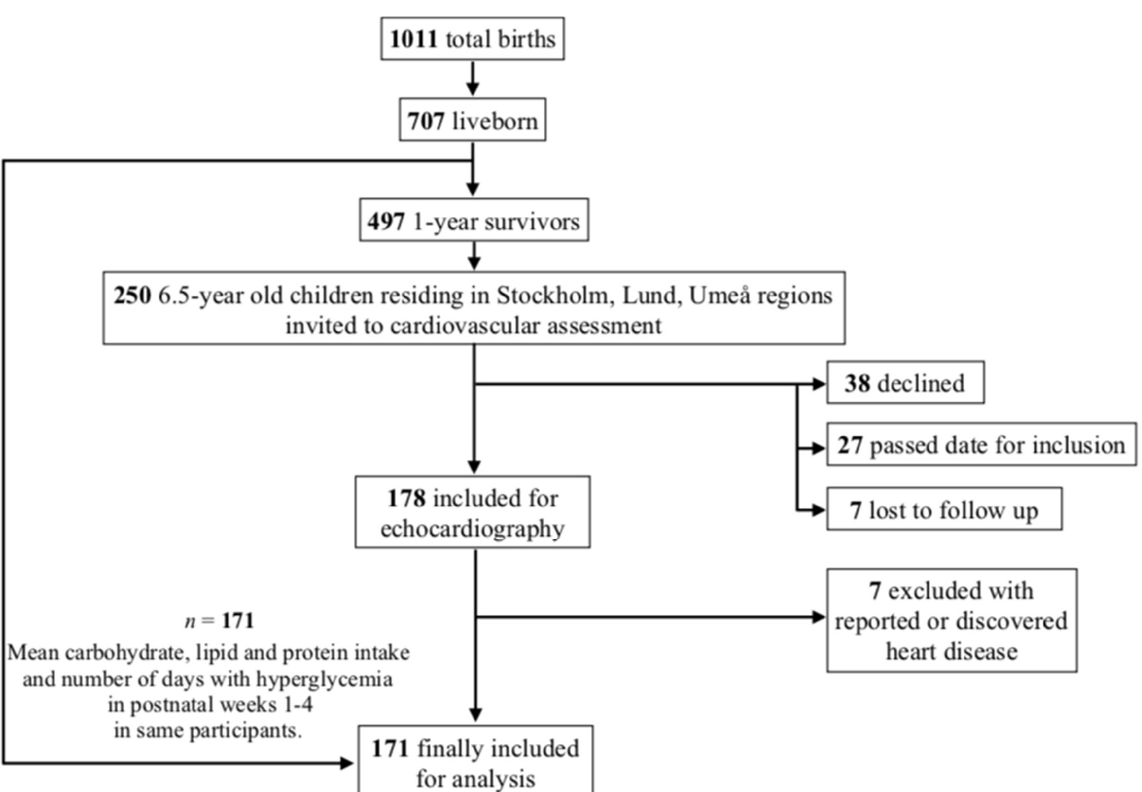
Figure 1. Study flow chart for participant selection included for analyses.